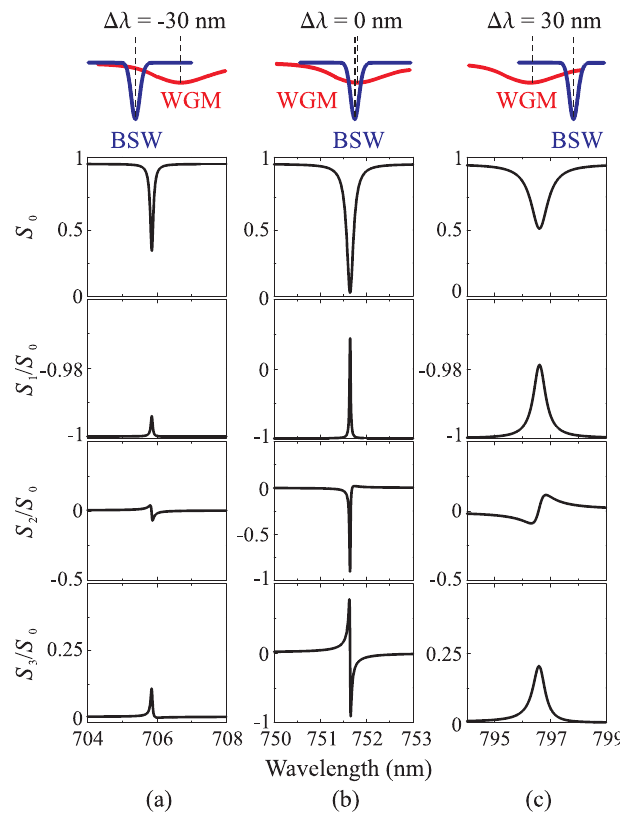
Figure 8. Numerical spectra of the Stokes parameter S 0 and normalized Stokes parameters S 1 / S 0 , S 2 / S 0 and S 3 / S 0 of light reflected by the magnetophotonic crystals in the presence of a magnetic field. The incident light is an s -polarized plane wave. Data are presented for the cases when the BSW resonance is ( a ) blue-shifted by 30 nm, ( b ) red-shifted by 30 nm relative to the waveguide mode (WGM) resonance, and ( c ) has the same spectral position as the WGM resonance. Reprinted with permission from M.N. Romodina, I.V. Soboleva, A.I. Musorin, Y. Nakamura, M. Inoue, A.A. Fedyanin, Phys. Rev. B 96, 081401(R) (2017). Copyright (2017) by the American Physical Society